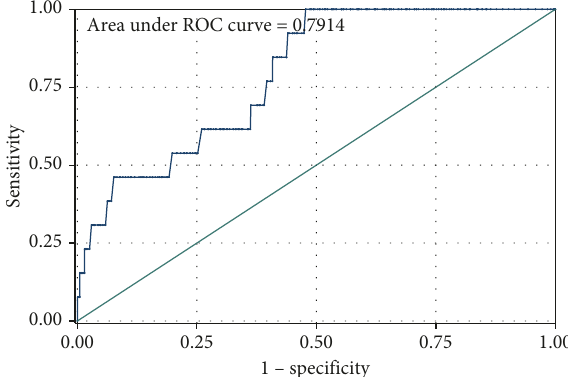
Figure 3: The ROC curves of predictive models in modeling groups